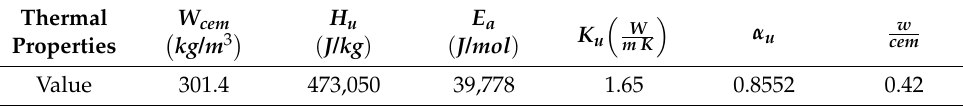
Table 5. Summary of thermal properties of 50% GGBFS mix